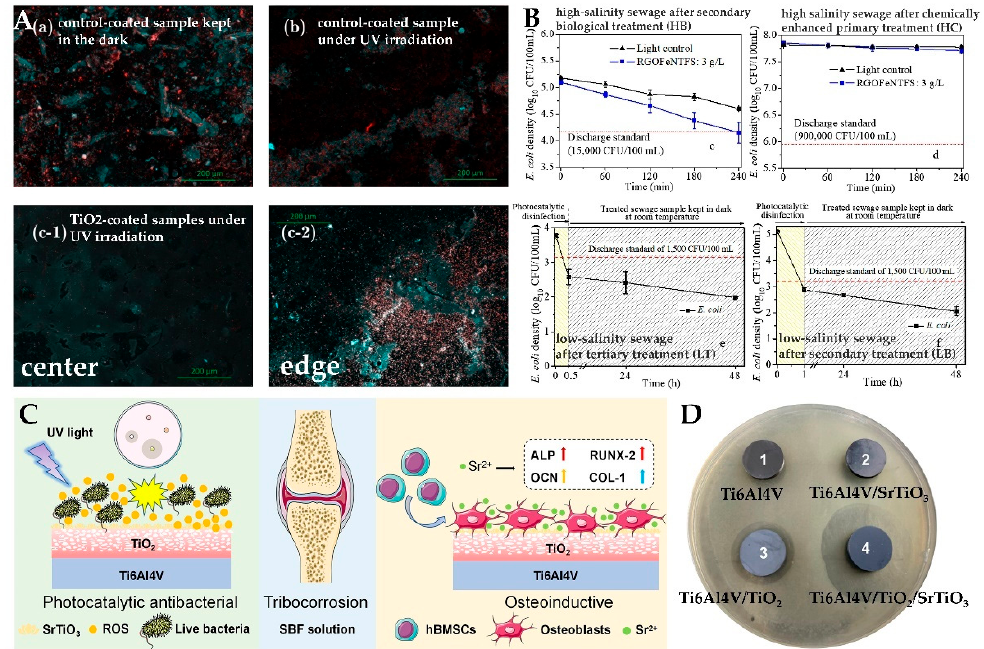
Figure 15. ( A ) Epifluorescence images of surface samples after 24 h of the experiment (blue color represent the coating and red to highlight the bacteria) [146]; ( B ) photocatalytic disinfection performance of sewage samples and the light control tests of ( c ) HB and ( d ) HC under simulated solar light at 25 °C; and regrowth test of inactivated bacteria (24 h and 48 h after reaction) in ( e ) LT and ( f ) LB [148]; ( C ) schematic diagram of TiO 2 /SrTiO 3 function; ( D ) bacteriostatic circles of different samples after 24 h [152].